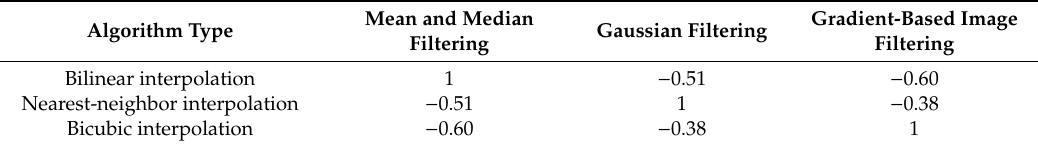
Table A14. The Pearson correlation coe ffi cients of the di ff erent image pyramid methods using IS. It confirms that our sample accuracy was independent.